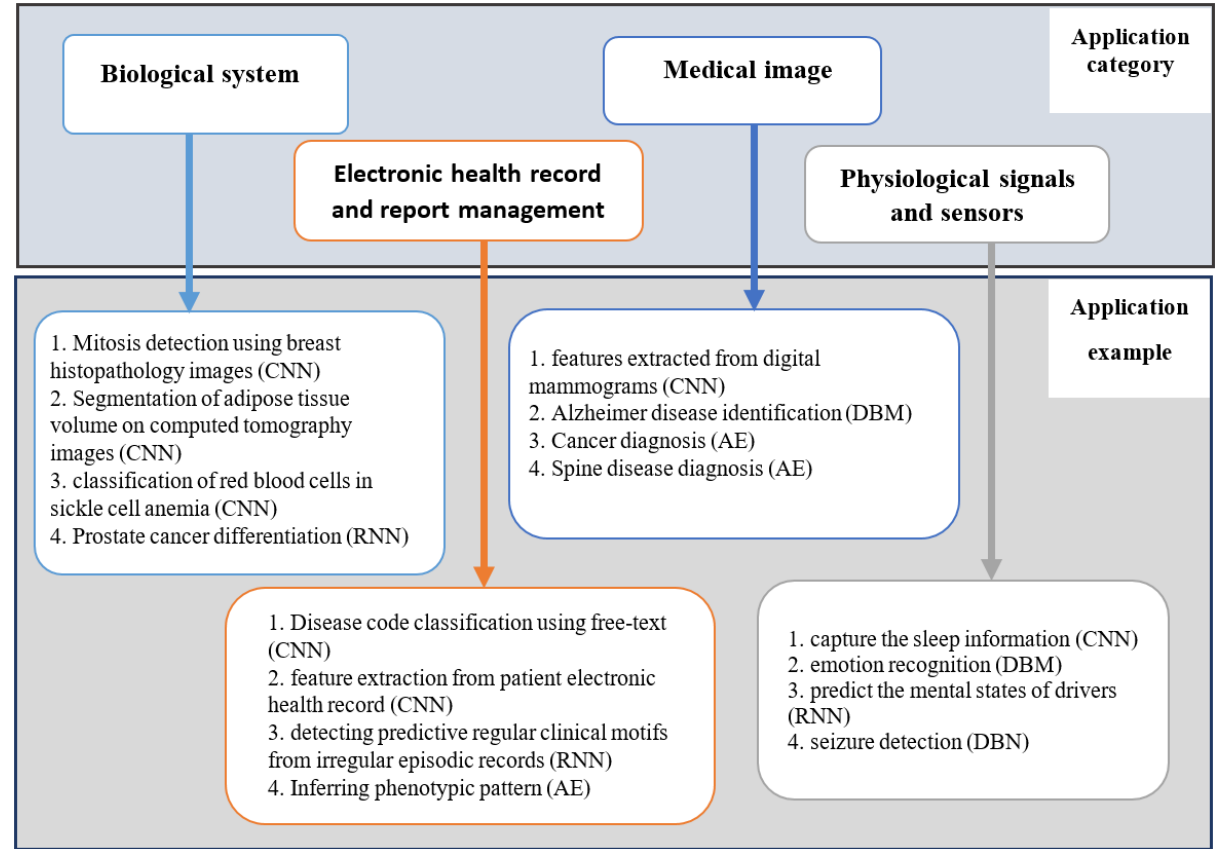
Figure 14. Descriptive summary of biomedical and health applications category and example implemented with deep learning methods: